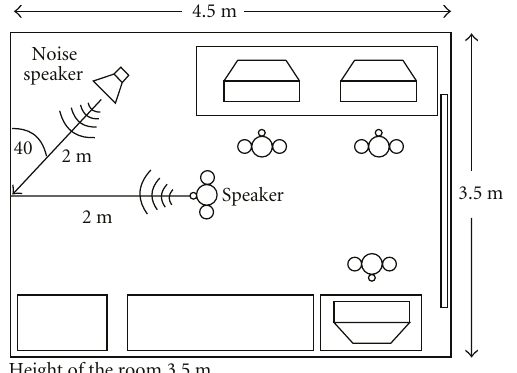
Figure 6: Map of experimental room, showing the position of the talker, noise source, and computers.